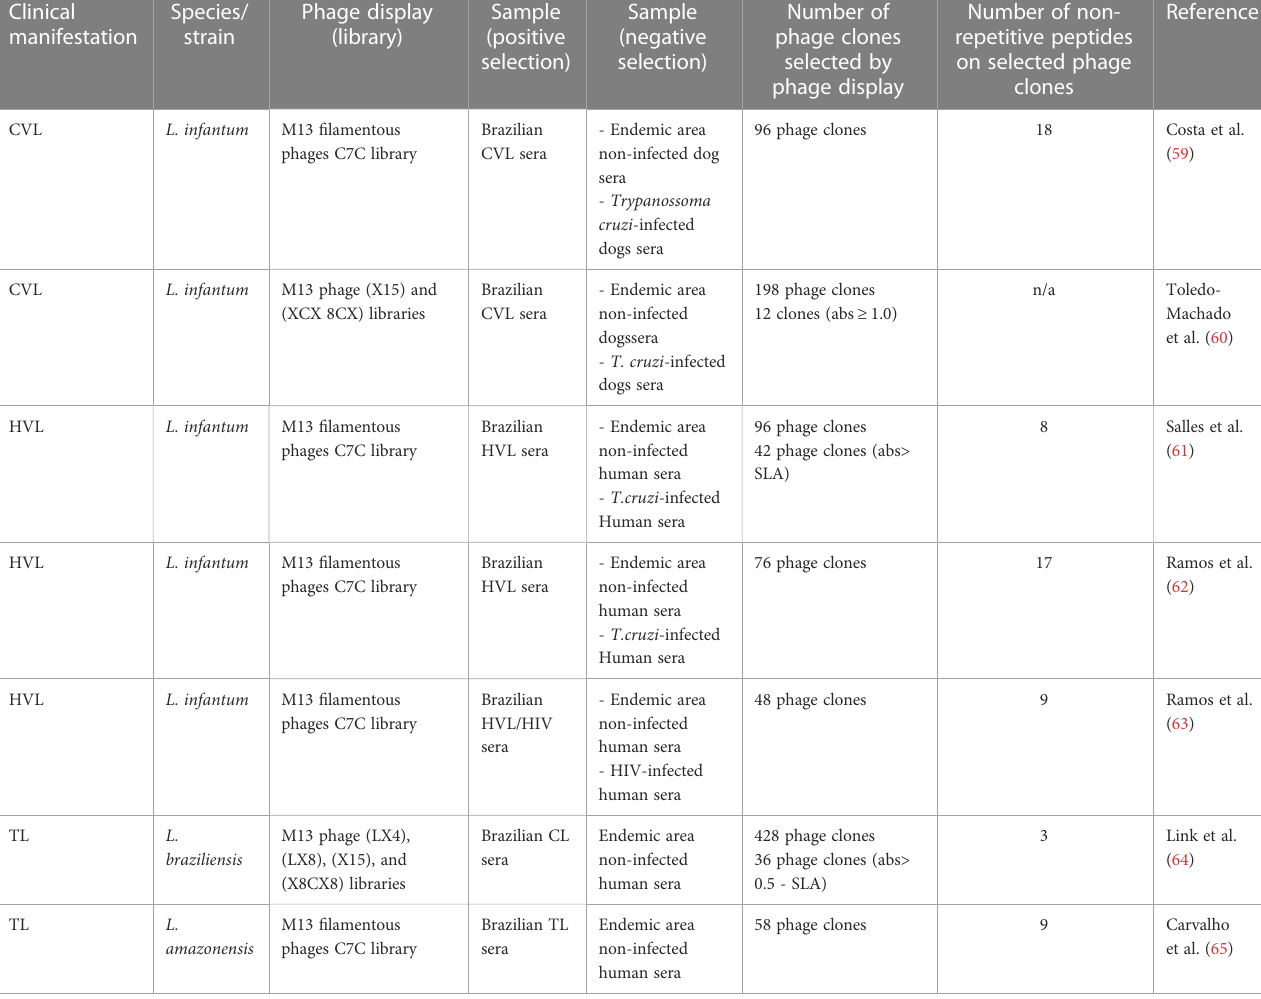
TABLE 2 Summary of Leishmania phage display studies. Clinical